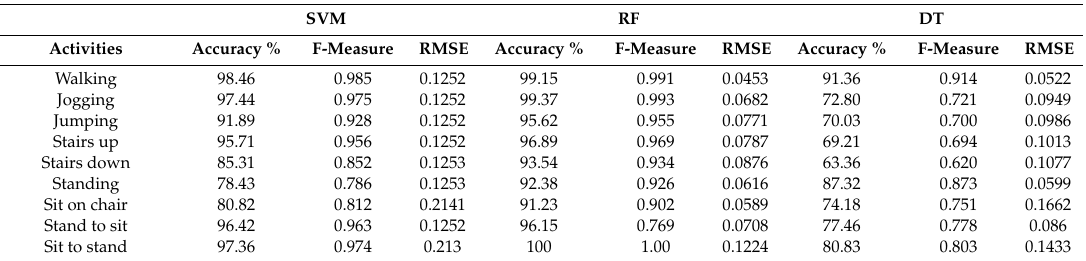
Table 4. Results of user recognition based on performance metrics for selected activities in the MobiAct